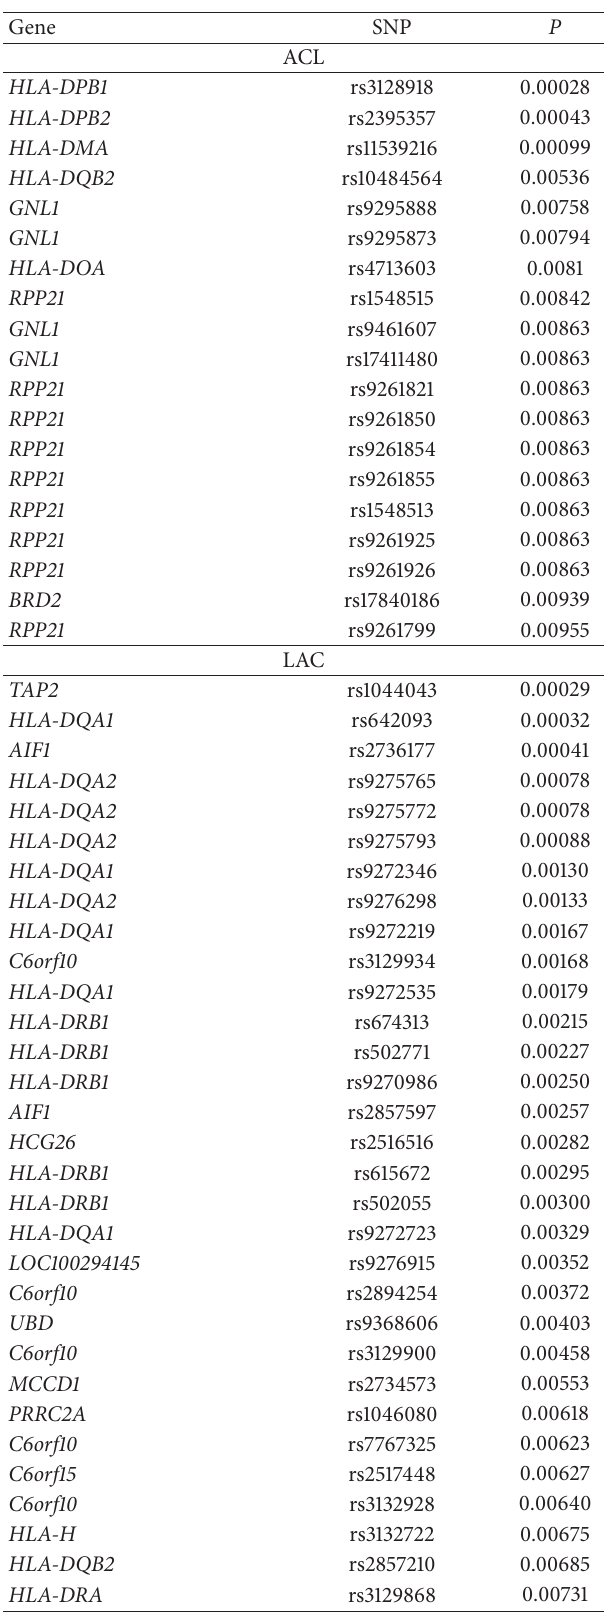
Table 6: Significant SNPs with 𝑃 < 0.01 in the MHC region on chromosome 6 for ACL, LAC, and Anti- 𝛽 2 GP1 ∗